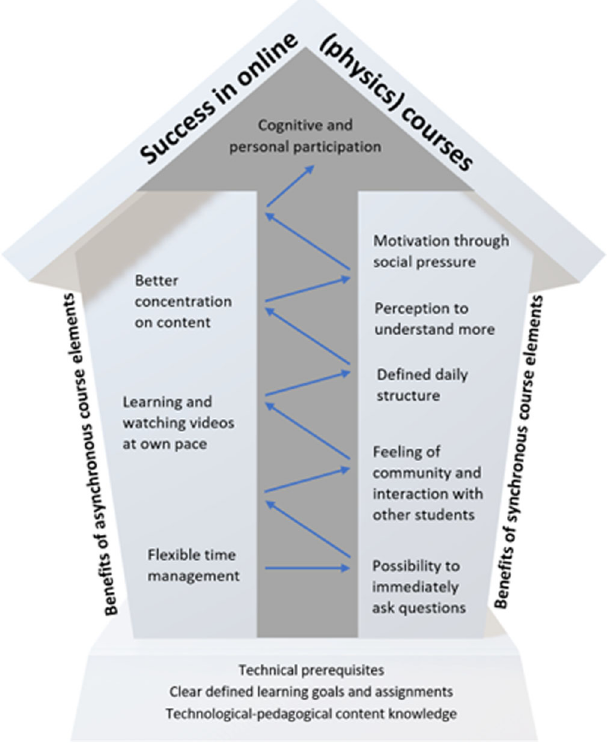
FIG. 4. Model for use of synchronous and asynchronous course formats. The pillars represent the benefits of asynchronous and synchronous course formats that lead to success in online (physics) courses. The arrows represent the interconnection between these formats and a need that they go together and supplement each